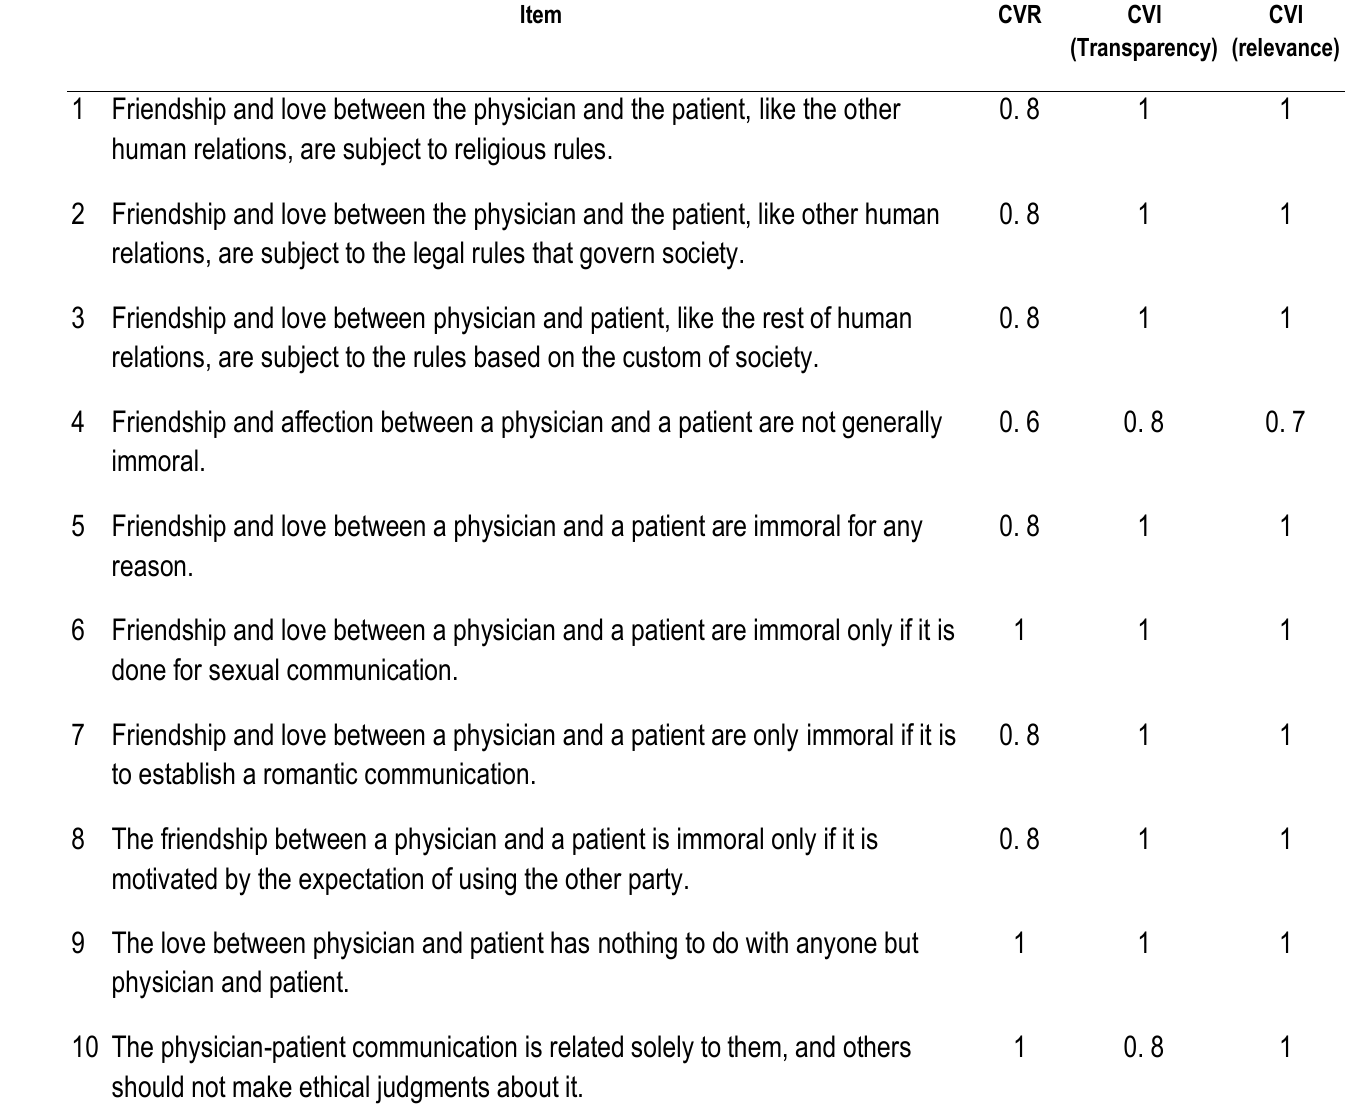
Table 2. Face and content validity and the final tool assessing physicians' attitudes toward establishing personal and friendly communication with patients